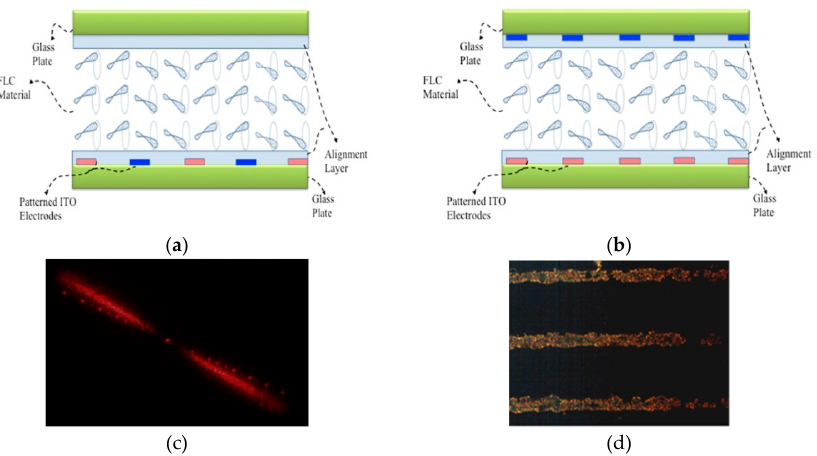
Figure 22. ( a ) The schematic of the FLC grating cell with inter-digital electrodes, the blue means positive and red means negative charge. ( b ) the schematics of the FLC grating cell with periodic vertical electric field. ( c ) Diffraction pattern of FLC grating describe in (a). ( d ) Texture of defects after